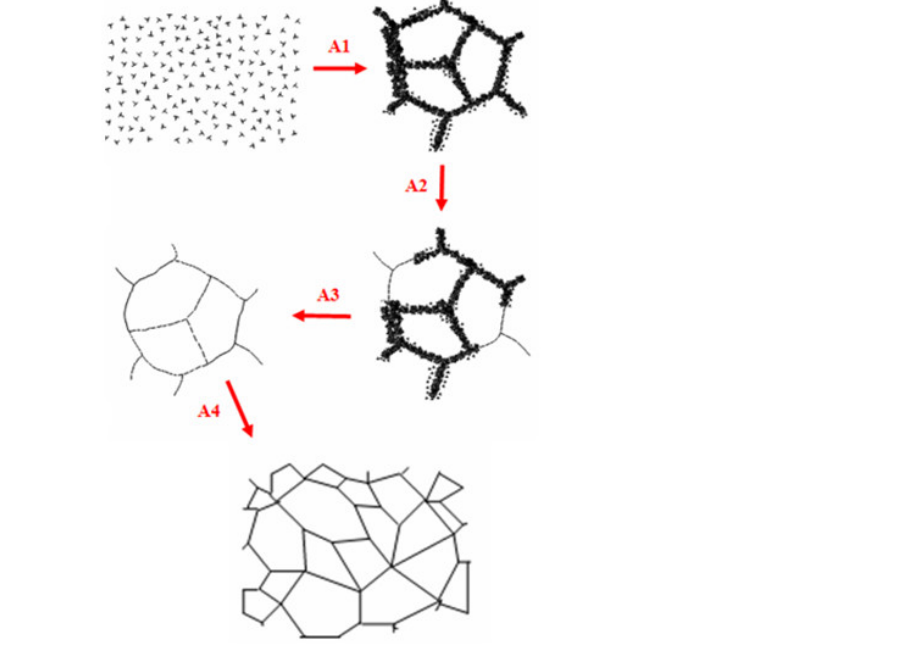
Figure 9. Schematic diagram of dynamic recrystallization in the matrix of W f /Cu 82 Al 10 Fe 4 Ni 4 com- posites.